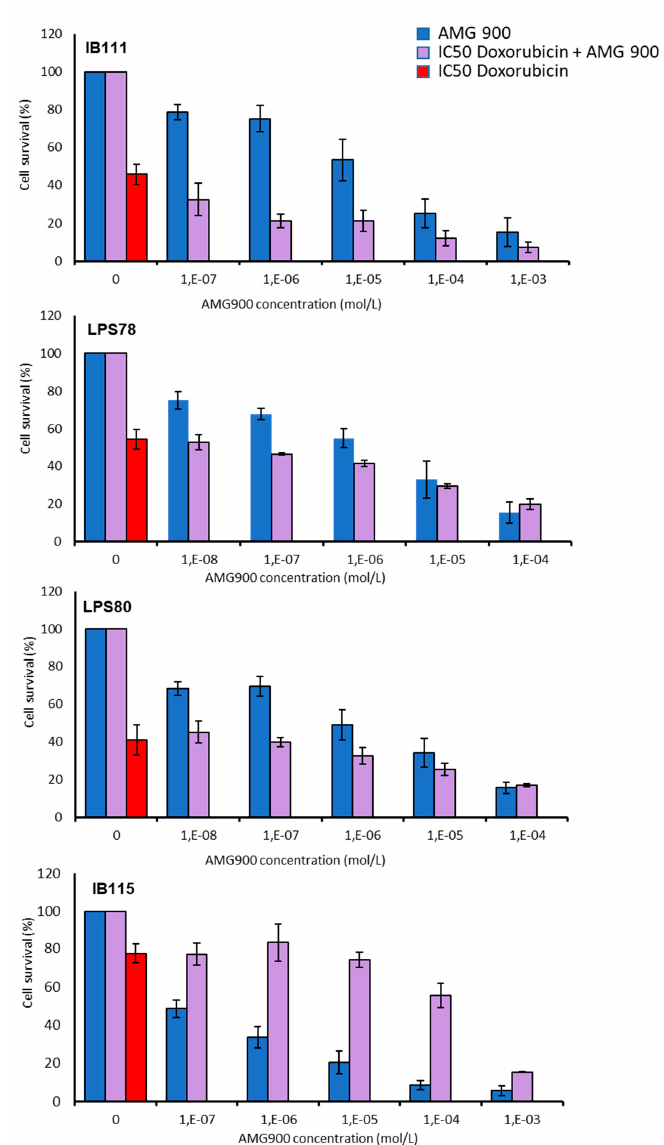
Figure 8. Doxorubicin-AMG 900 combined chemotherapy is efficient to induce cell mortality. LPS cells are challenged with IC 50 of doxorubicin or a dose range of AMG 900 alone or in combination for 72H. Cell survival is assayed by MTT. Histograms are mean values of triplicate +/ − SEM.